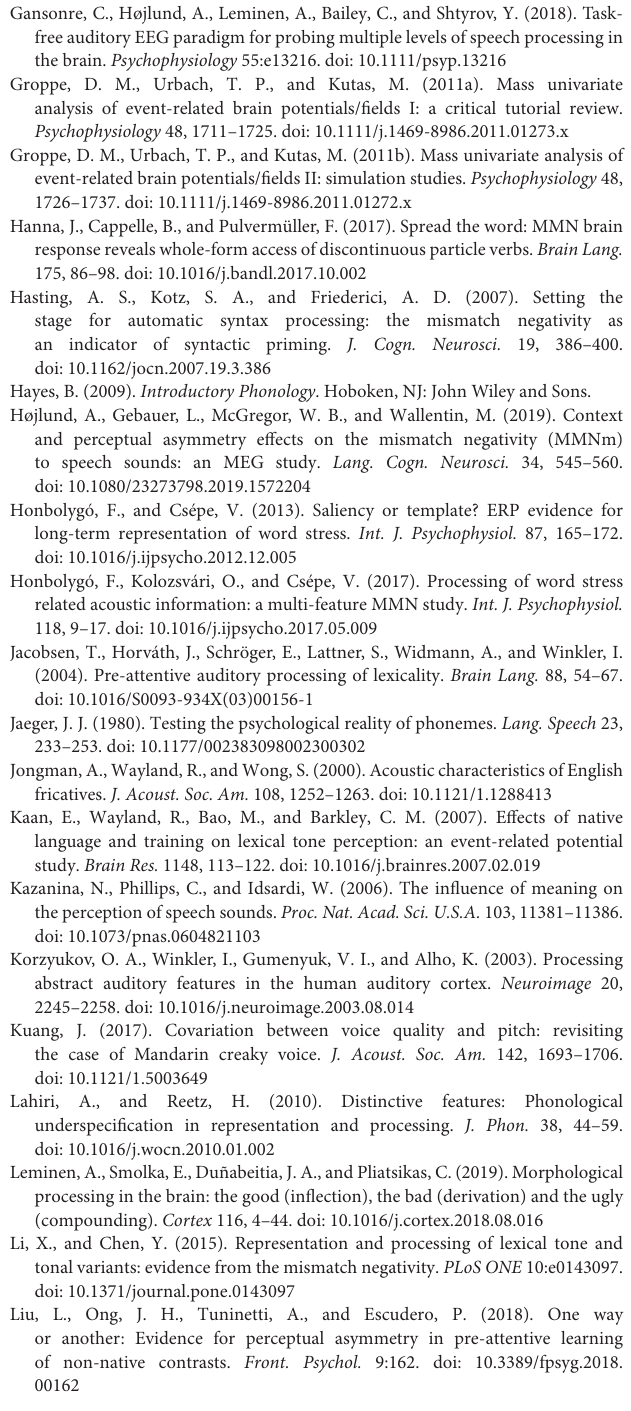
Supplementary Table 2 | Intensity information (measured in dB) of the original stimuli: (1) the initial fricative /x/ without vocal-fold vibration; (2) the voicing portion